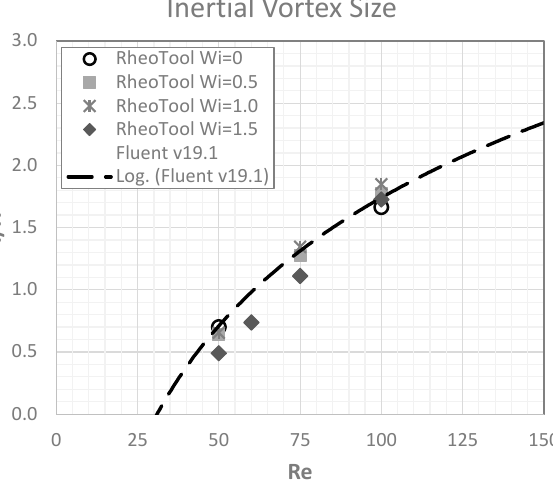
Figure 9. Non-dimensional inertial vortex length for polymer flow vs. Reynolds number.